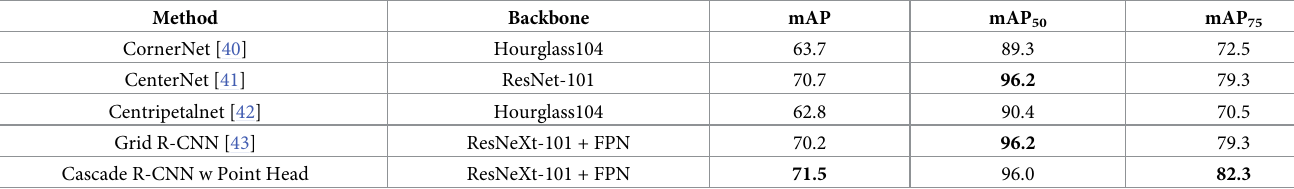
Table 5. Comparison of the performance of the point head with state-of-the-art keypoint-based object detectors on the CargoX dataset.